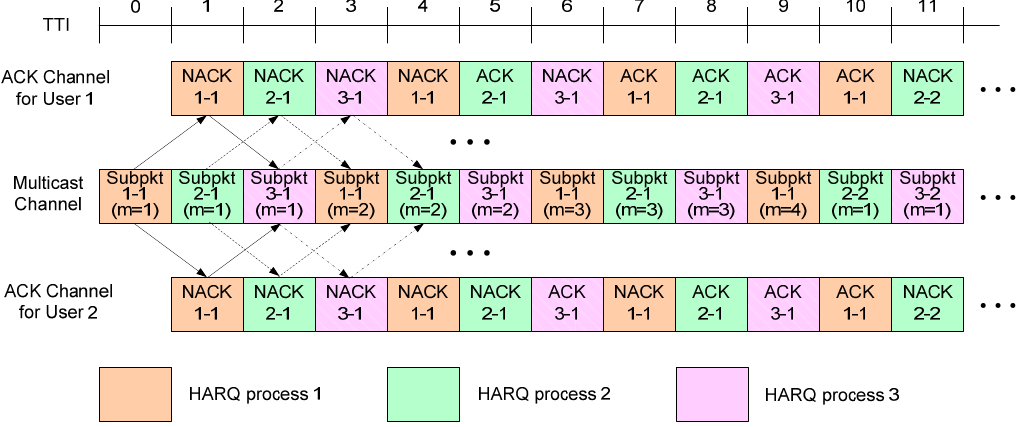
Figure 1. Conventional HARQ scheme. Subpkt x - y ( m = n ) means the n -th transmission of the y -th HARQ packet by the x -th HARQ process.